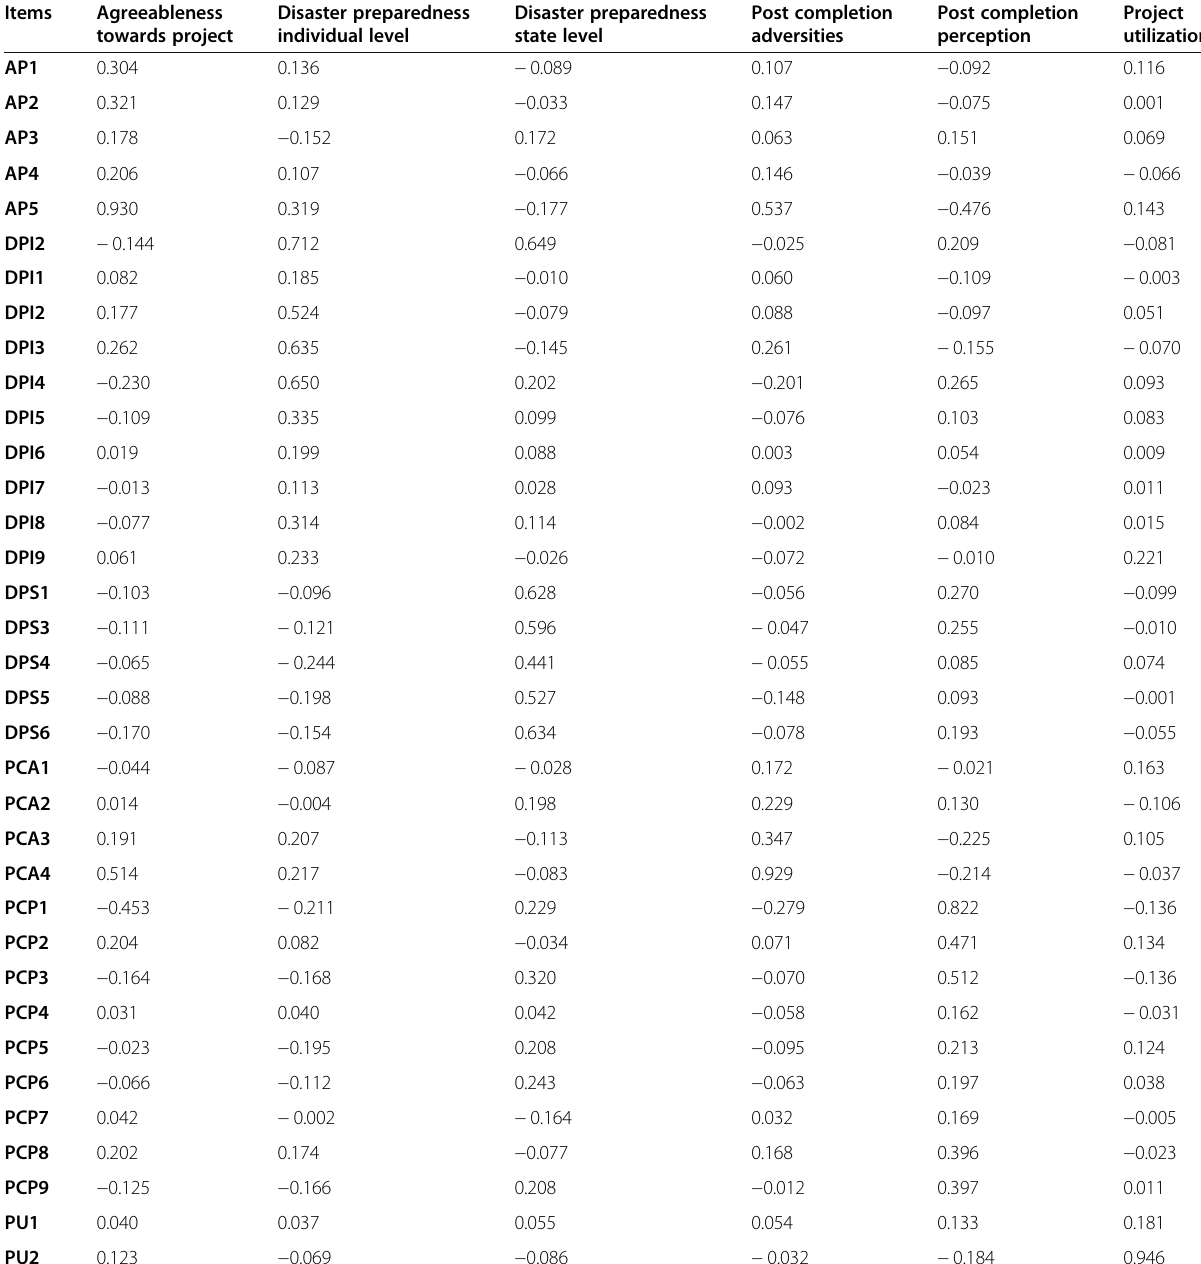
Table 6 Instrument ’ s discriminant validity (cross loadings)